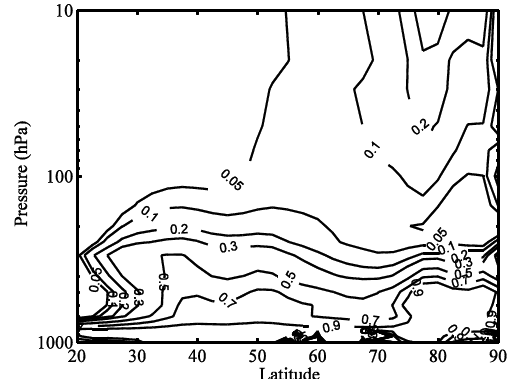
Figure 5. Climatology of vertical component of EP flux normal- ized by vertical component of EP flux at 850hPa for DJF at North- ern Hemisphere. Discontinuity of this quantity at the tropopause heights indicates the strong suppression of wave penetration from troposphere into the stratosphere at lower stratosphere. Chen and Robinson (1992) discuss the importance of the abrupt change of the buoyancy frequency at the tropopause level for the suppression of the upward wave